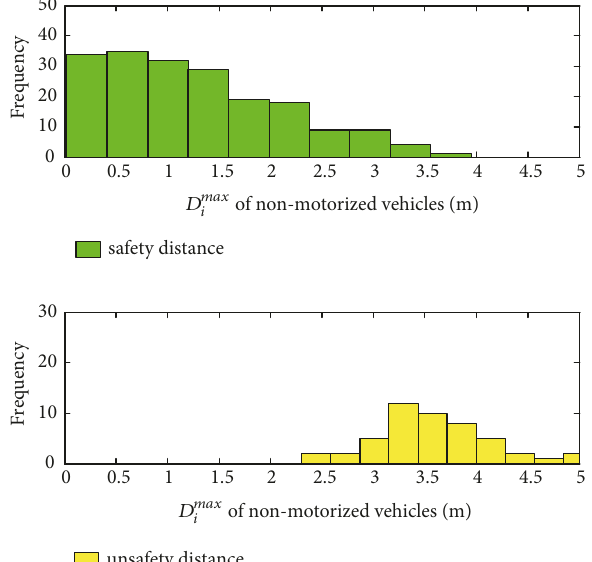
Figure 7: Histograms of the safe and unsafe occurrences with respect to the 𝐷 𝑚𝑎𝑥 𝑖 of nonmotorized vehicles at the Xianxia-Jianhe